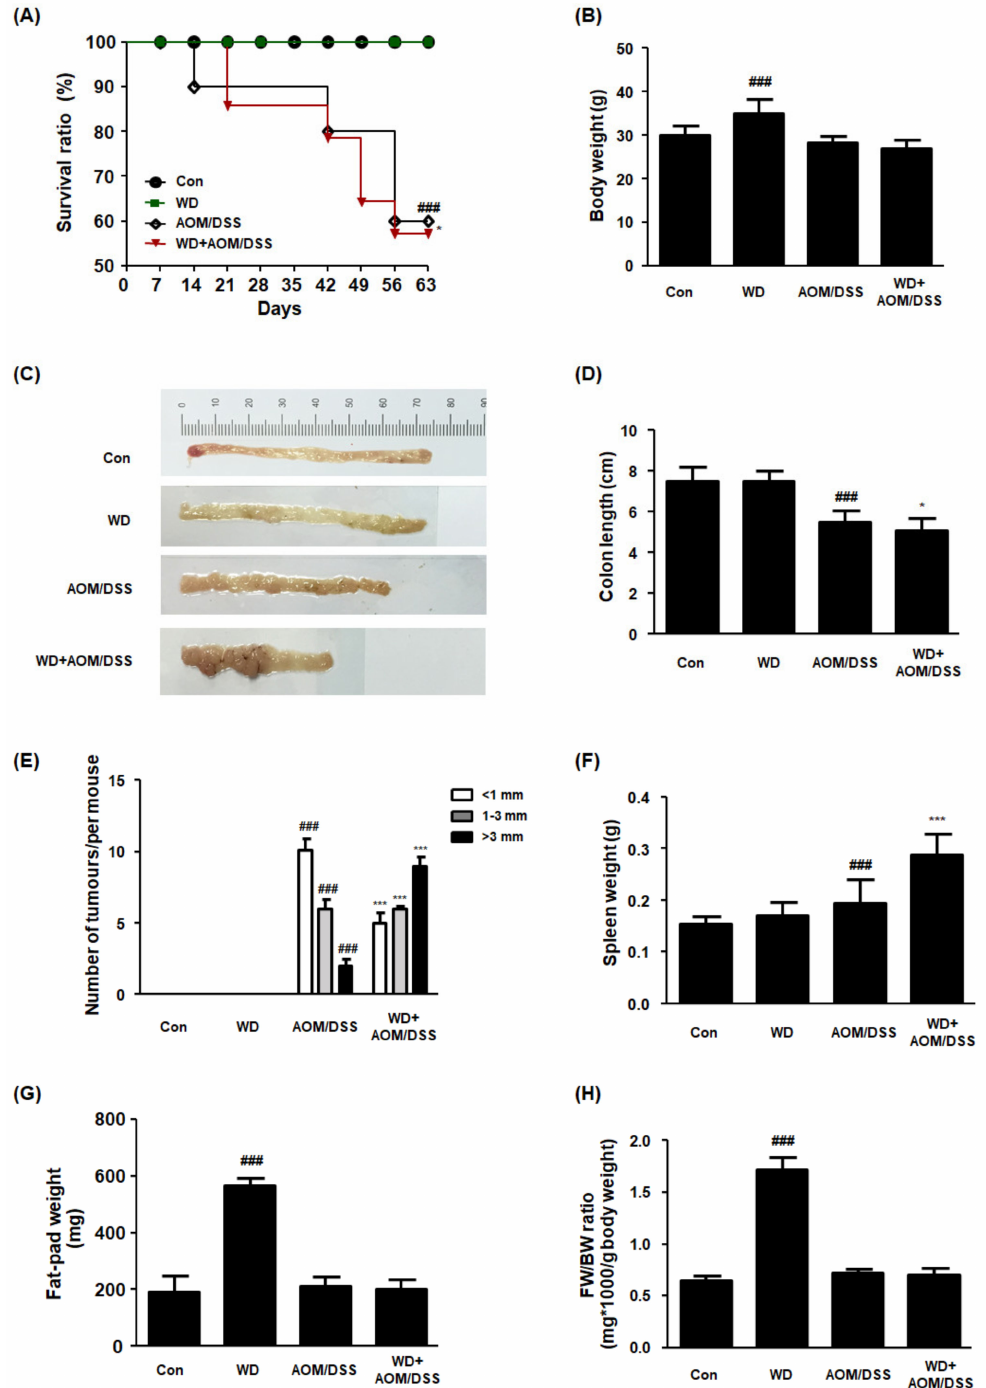
Figure 1. Effect of WD consumption on the development of CAC in an AOM/DSS-induced CAC mouse model. All mice were allocated to four groups: control mice (Con), Western-diet-fed mice (WD), AOM/DSS-induced CAC mice (AOM/DSS), and AOM/DSS-induced CAC mice fed WD (WD + AOM/DSS). ( A ) Survival ratio. Data were analyzed by Kaplan–Meier survival analysis ( n = 11); ( B ) body weights for each mouse group; ( C ) representative photographs of colon tissues from each group; ( D ) colon lengths; ( E ) number of macroscopic tumors. The colon length was estimated from the cecum to the proximal rectum. All multiple nodular masses were counted as a tumor in colonic tissues in a blinded manner. ( F ) Splenic weight; ( G ) fat-pad weight; ( H ) FW/BW ratio. FW/BW ratio = fat pad weight in each mouse (mg) × 1000/body weight for each mouse ( G ). The values are the means ± SD ( n = 6); ### p < 0.001 when compared to Con; * p < 0.05 and *** p < 0.001 when compared to